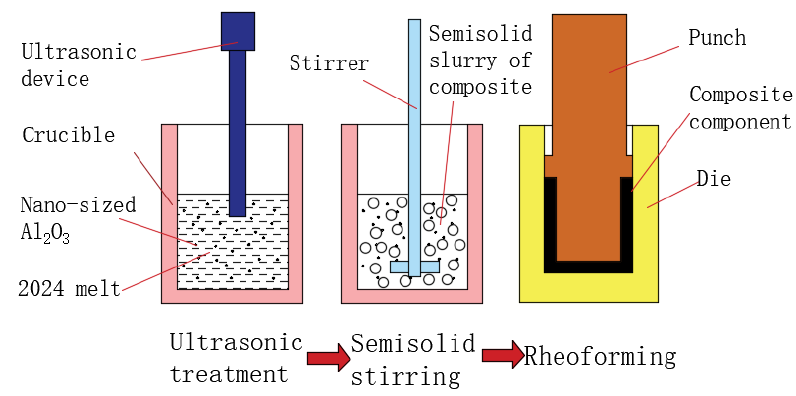
Figure 1. Schematic diagram of fabricating and rheoforming the semisolid slurry of composite.